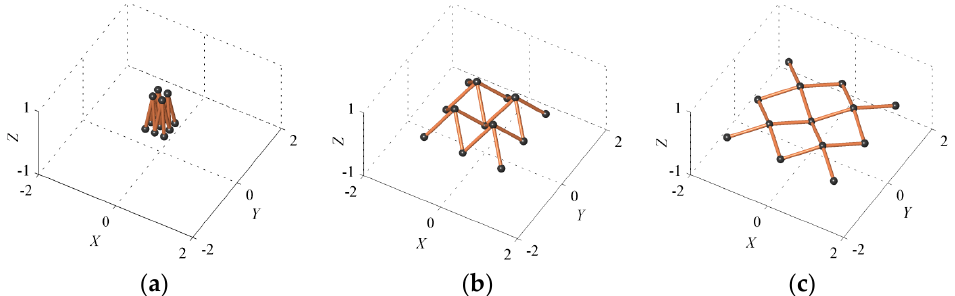
Figure 3. Motion of a deployable structure assembled by 2 2 × basic units, with n 1 = n 2 = 4: ( a ) Folded configuration; ( b ) partially deployed configuration; ( c ) deployed configuration.